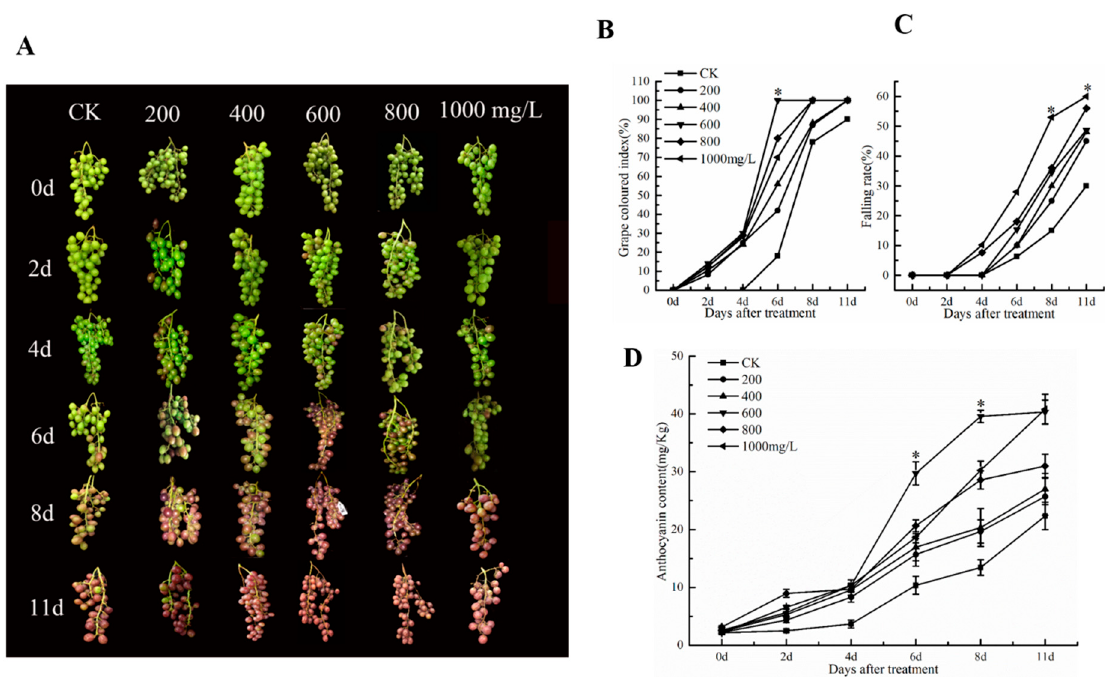
Figure 1. Effect of ethephon on coloring and threshing in grape. ( A ) Morphology of grape clusters. ( B ) Grape colored index. ( C ) Falling rate of grape fruit. ( D ) Changes of anthocyanin content in grape. Ethephon was used in different concentrations (200, 400, 600, 800, and 1000 mg/L) and in a time course experiments (2, 4, 6, 8, and 11 days). Values are means ± SD of five biological replicates. * Significant differences compared with the control (water-treated fruits) at p < 0.05, using Student’s test. d: days.